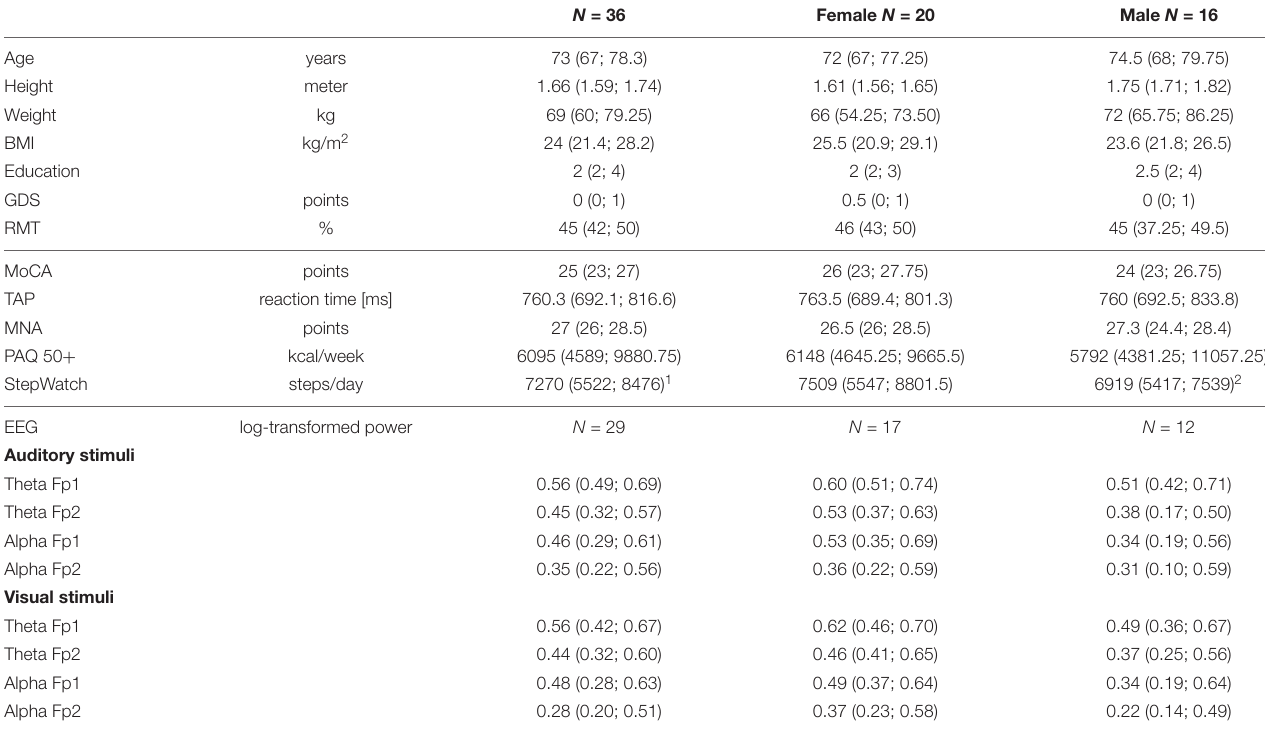
TABLE 1 | Participants’ characteristics and test